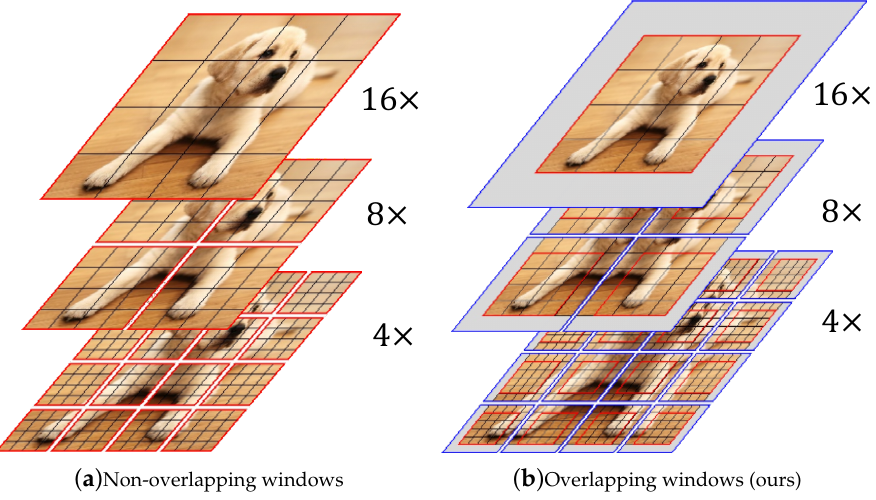
Figure 1. Different window partitions used in Swin-Transformer and our proposed LGViT. ( a ) For non-overlapping windows used in Swin-Transformer, the self-attention module is performed within each local limited window. ( b ) For overlapping windows used in LGViT, the feature map will be padded if needed and the self-attention module is conducted within each locally enhanced